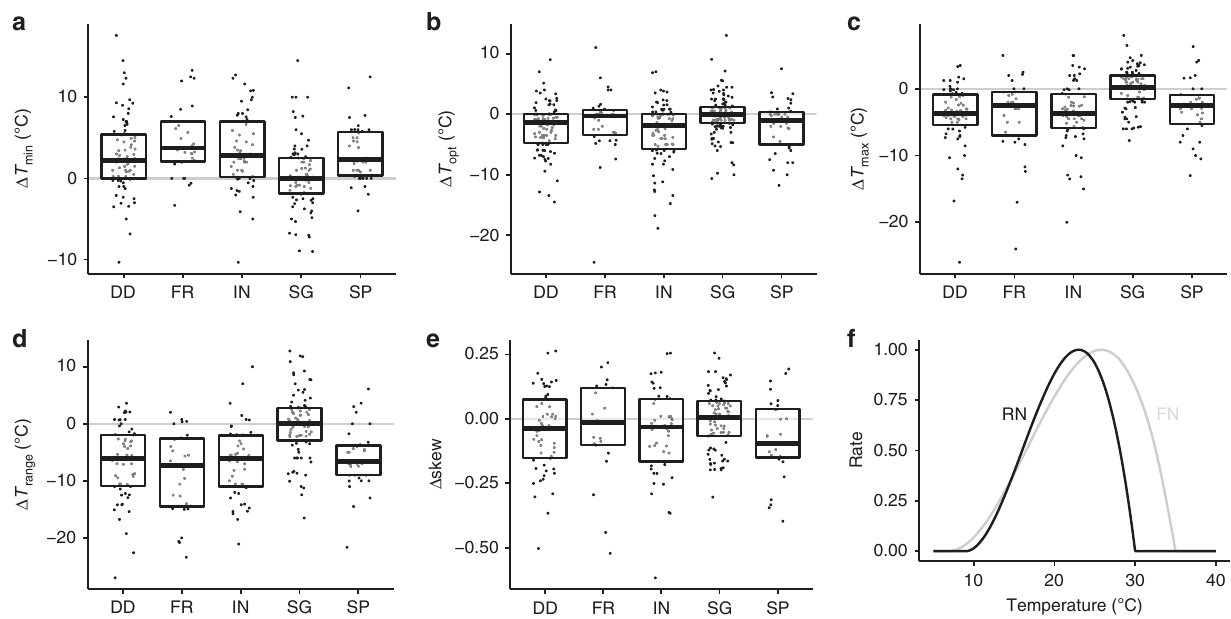
Fig. 2 Temperature response differences to growth in culture. a T min , b T opt , c T max , d T range and e Skew. Processes are disease development (DD), fruiti fi cation (FR), infection (IN), spore germination (SG) and sporulation (SP). a – e Boxplot boundaries re fl ect the inter-quartile range, the horizontal bar is the median. Summary statistics including sample sizes are reported in Supplementary Table 2. f Illustration of temperature response (beta function) for the fundamental niche (grey, represented by growth in culture) compared with the realized niche (black, represented by disease development), where RN has a narrower T range and lower T opt than